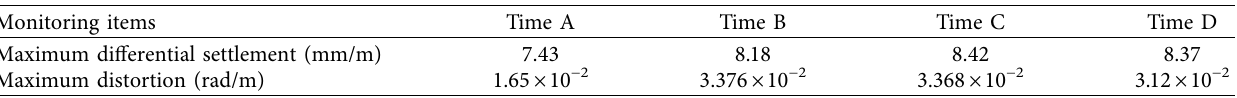
Figure 9: Settlement time history of the crucial measuring points in the whole process of the cut pile construction. Table 3: Maximum differential settlement and maximum distortion of the building at each critical moment in the construction of shield cut group piles.